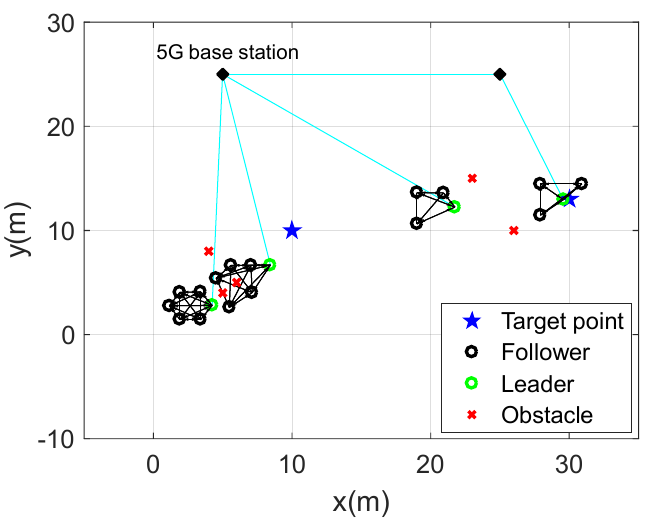
Figure 9. Optimal topology considering information interaction between two clusters. The figure shows the formation of the two sampling points in the task execution process of the two clusters after optimization. At the first sampling point, cluster 1 remains in the desired shape, while cluster 2 is being adjusted. At the second sampling point, cluster 1 is avoiding obstacles and cluster 2 is completing its task and maintaining the desired formation.